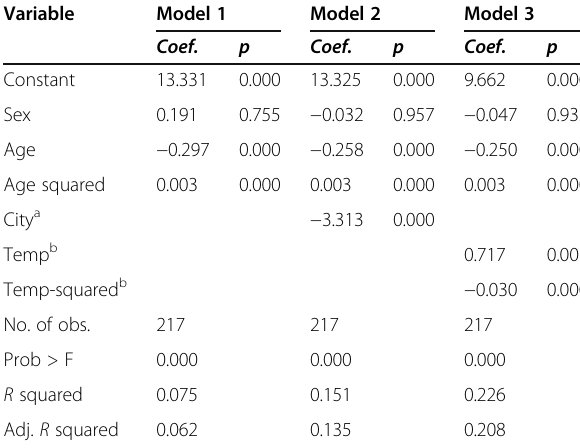
Table 5 Regression results for the geographical disparities in the incubation